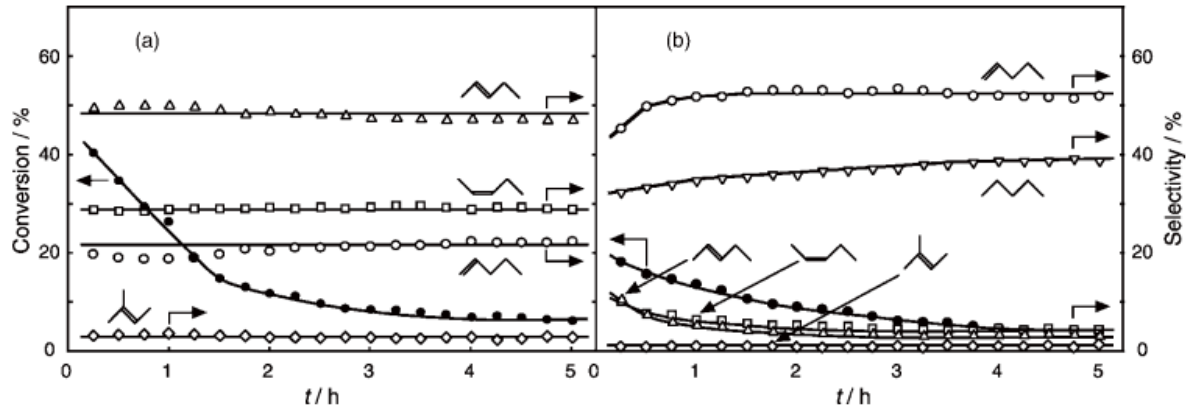
Figure 35. Catalytic activity and selectivity of Re dehydrohalogenation and hydrogenolysis of 1-chloropentane (0.20 mL/h, 1.66 mmol) in a stream of ( a ) helium; and ( b ) hydrogen at 300 °C. Other conditions are the same as in Figure